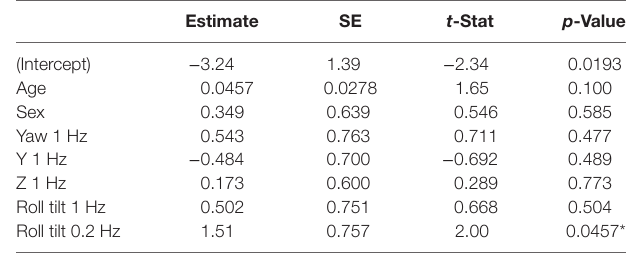
TaBle 2 | The reduction in correlation coefficients due to age adjustment of thresholds. roll 1 hz Yaw